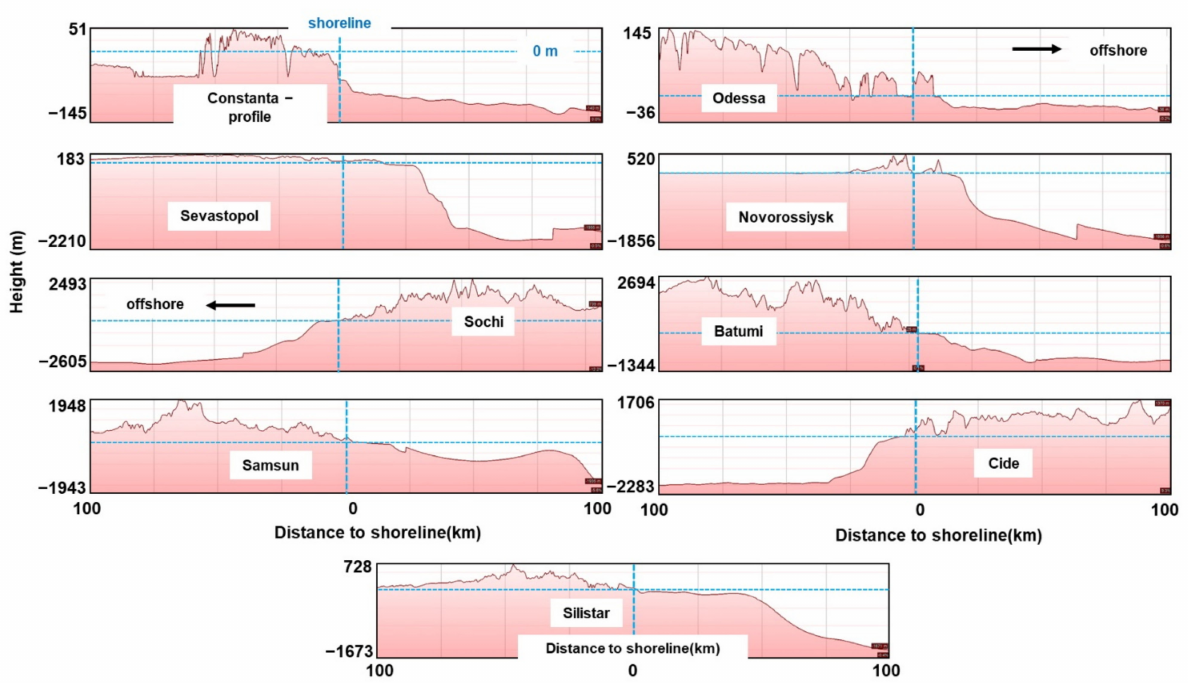
Figure 2. Profile lines represented for each coastal area taken into account. All the values are relative to the seafloor according to the information provided in Google Earth